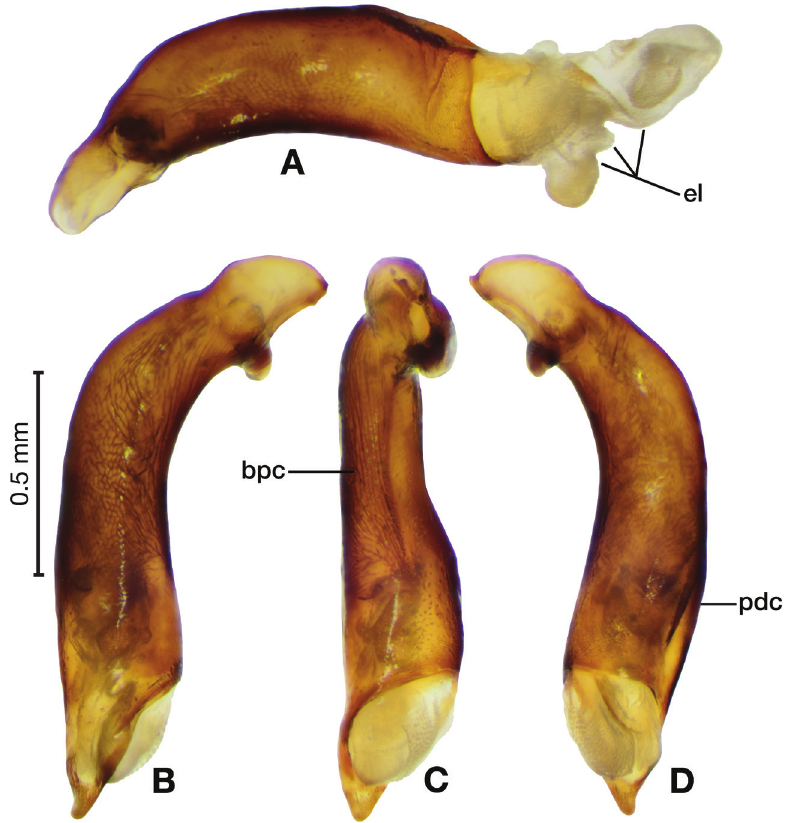
Figure 10. Digital images of male genitalia of Amphimenes carinacaulis sp. n.. A left lateral aspect, en- dophallus everted B right lateral aspect C ventral aspect D left lateral aspect. Legend: bpc basal phallic carina; el endophallic lobes; pdc preapical dorsolateral carina (apical endophallic sclerite not